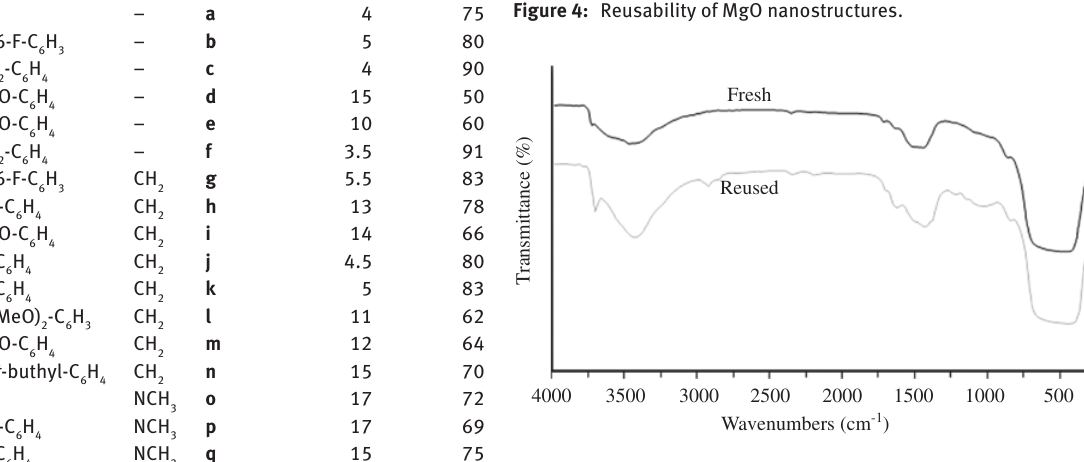
Figure 5: Fourier transform infrared (FT-IR) spectra of the fresh catalyst and the four-times reused